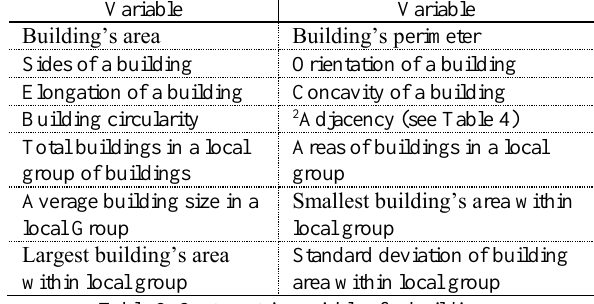
Table 3. Cartometric variables for buildings.